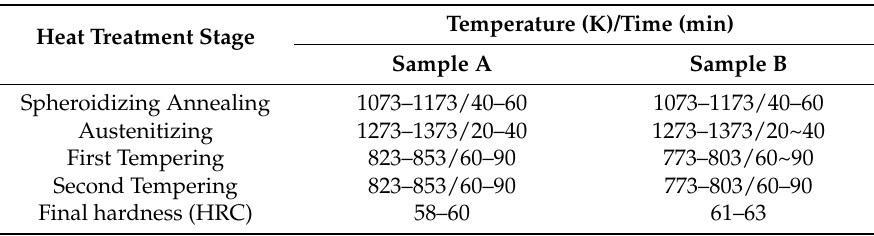
Table 2. Parameters for the heat treatment